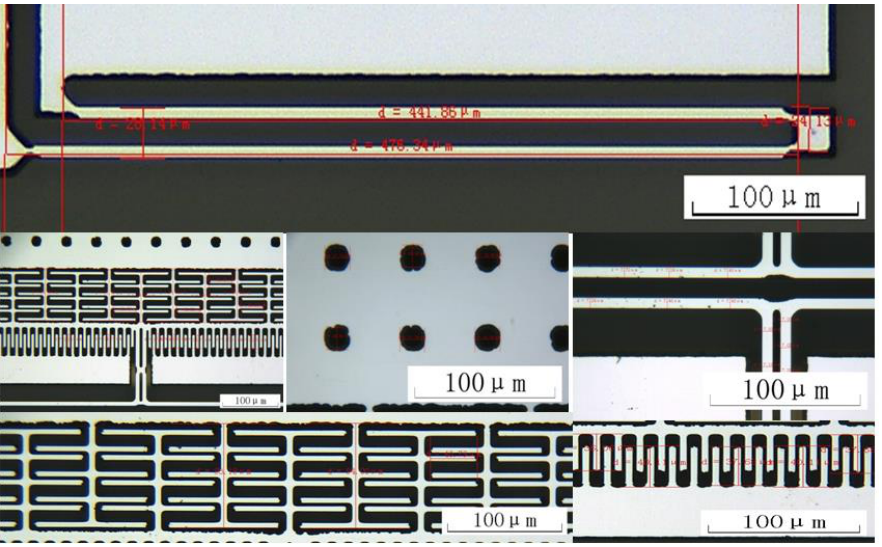
Figure 25. Computer vision measurement of the microstructure size. Table 3. Structure parameters of the accelerometer.